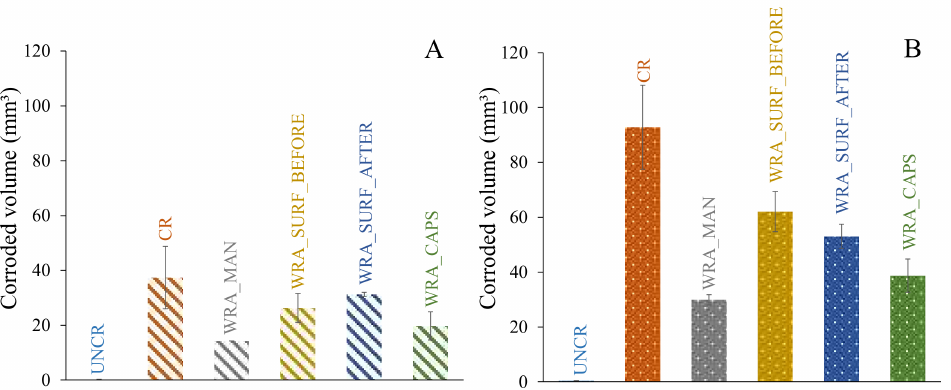
Figure 14. Average corroded volume of rebar calculated from the X-ray µ CT -scans ( A ) and the macro-cell corrosion current measurements ( B ) for each of the test series (for the series WRA_MAN and WRA_SURF_AFTER only one, respectively, two out of the three rebars could be investigated with X-ray µ CT and when considering the corrosion current measurements the WRA_MAN series consisted of only two replicates, error bars represent the standard